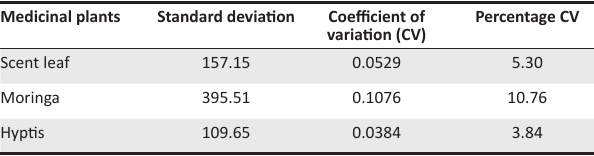
TABLE 9: Coefficient of variation in prices